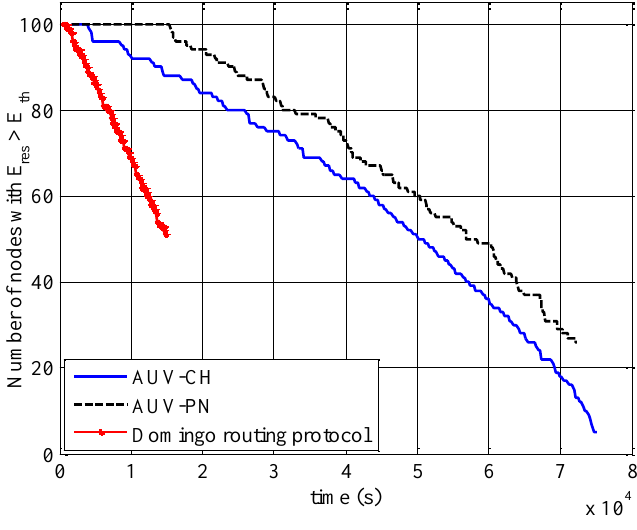
Figure 10. Number of nodes with residual energy E res > E th